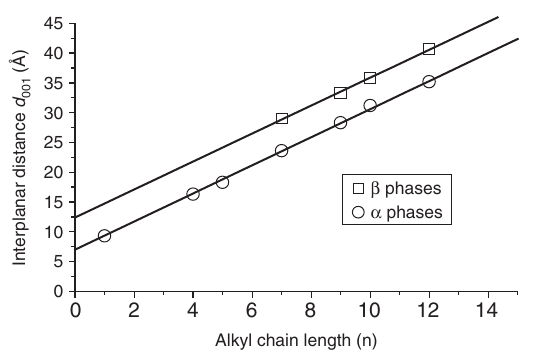
Figure 5: Temperature variation of the χ T product for copper compounds exchanged with n-alkyl-carboxylates of different carbon chain lengths. ) n = 1, acetate (metamagnetic), ) n = 7, α (antifer- romagnetic), ) n = 7, β (ferrimagnetic). Insert shows the magnetiza- ) for copper tion vs. field curve at 4 K of the β phase. Adapted with permission Figure 3: Variation of the interplanar distance ( d 001 hydroxycarboxylates in the α or β form (see text). from [81]. Copyright 1999 Royal Society of